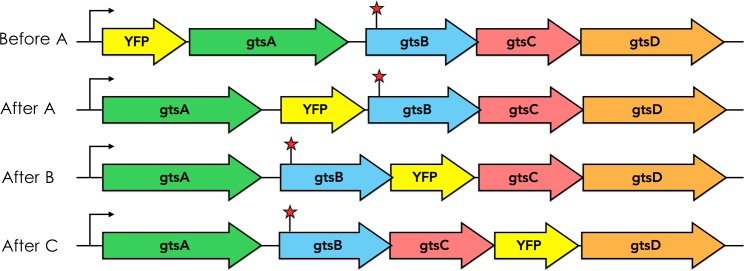
Schematic depicting positions of YFP transcriptional fusions within the native gts operon.